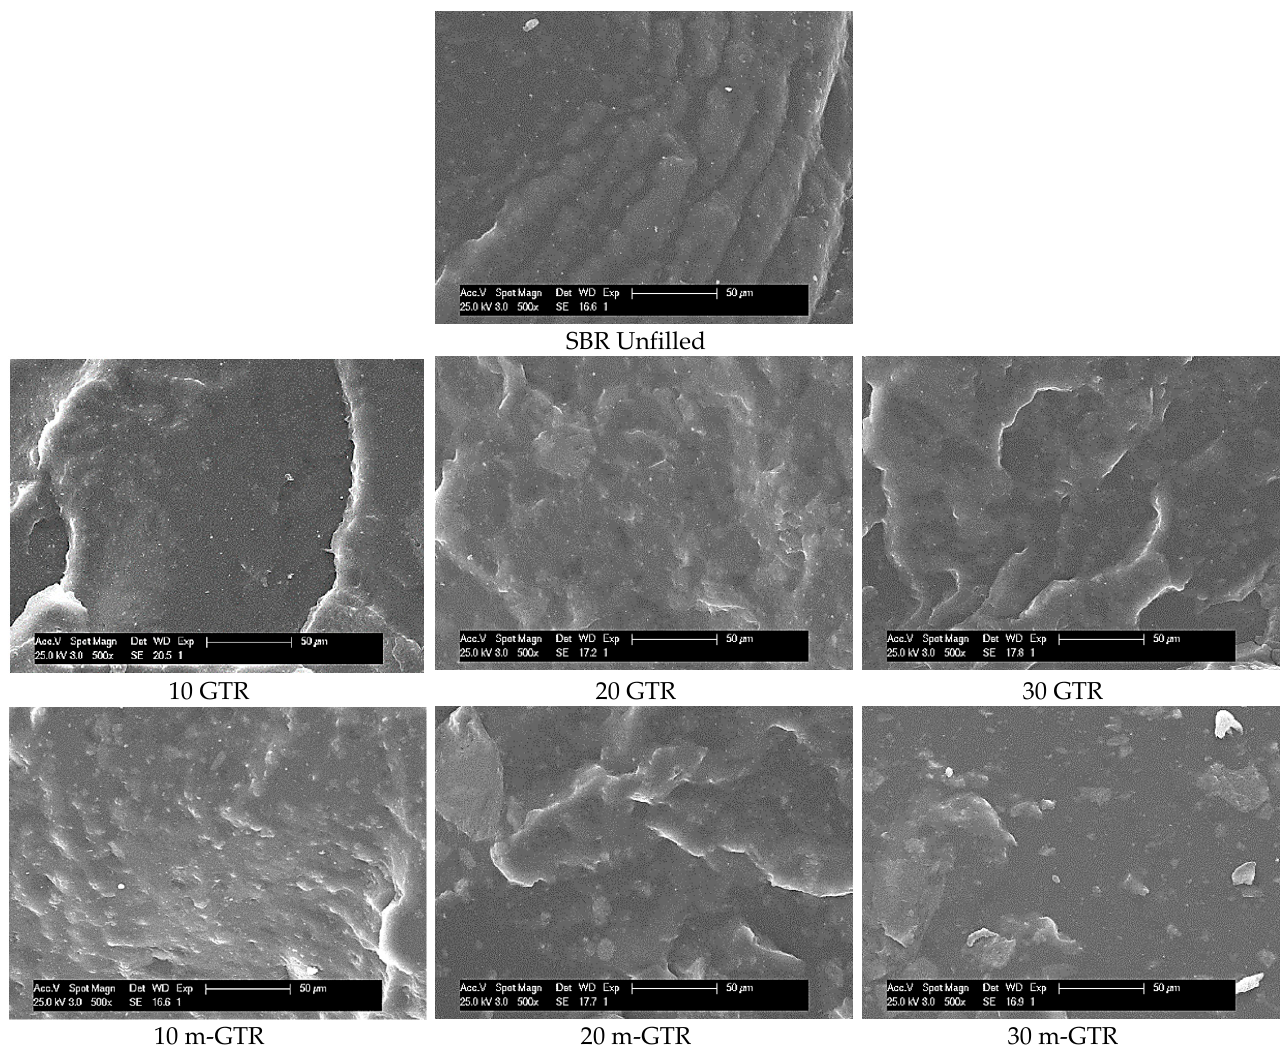
Figure 8. SEM fractographs of the unfilled and filled composites with different GTR and m-GTR content. Table 7. Dynamic-mechanical properties of GTR–SBR and m-GTR-SBR